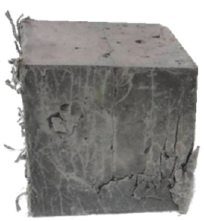
Figure 8. Destroyed fiber-reinforced concrete with polypropylene fibers (F-RCP) cubic specimen after the strength test.